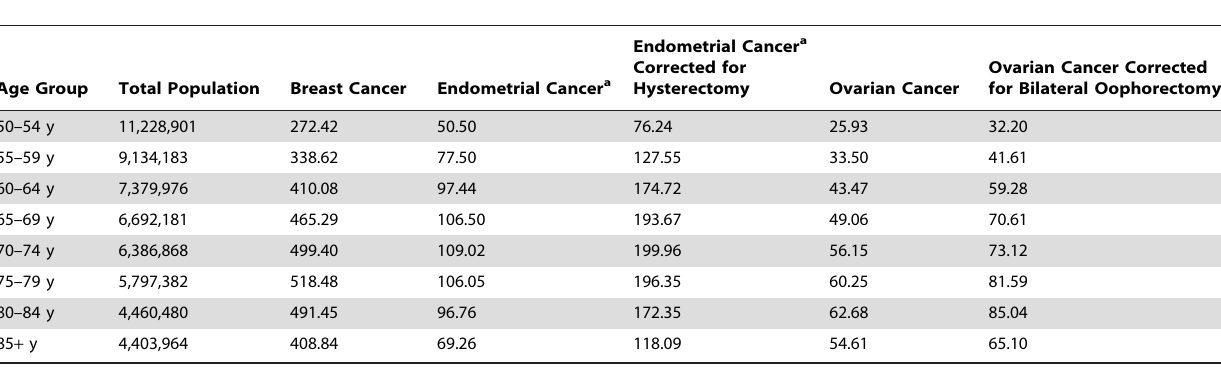
Table 4. 5-y age-specific SEER incidence rates, 1992–2006, for breast, endometrial, and ovarian cancers for white, non-Hispanic females in 13 SEER registries (Alaska excluded) that cover 14% of the US